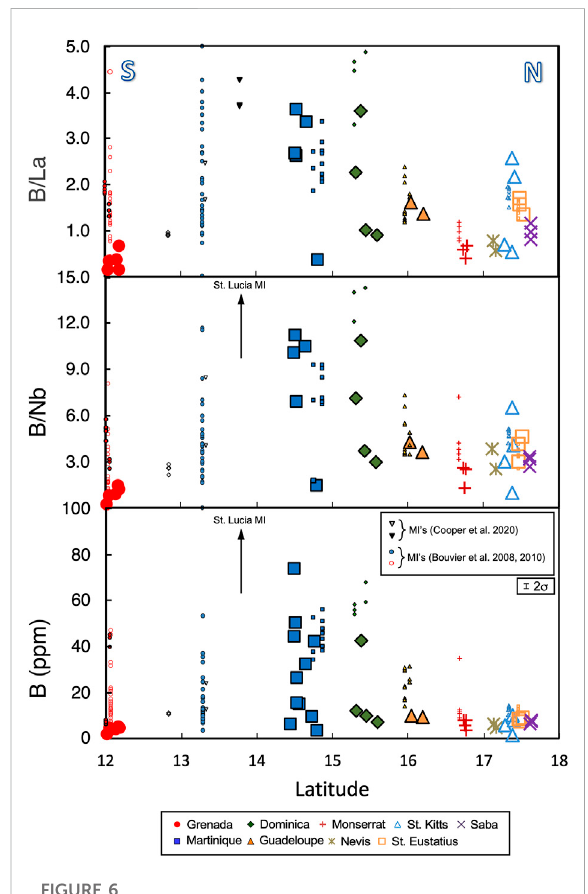
FIGURE 6 Variation of Boron, B/Nb and B/La for the Lesser Antilles Volcanic Arc. Boron is low in Grenada whole rock, enriched in the central islands, reaching peak concentration in St. Lucia and decreasing northward. Ba/Nb and Ba/La are very low for Grenada lava whereas these same ratios are slightly higher in the northernislandssuggestingthatbothNbandLaaremoreenriched in the south. Symbols as in Figure 3 with the addition of Grenada and St. Vincent MI ’ s (small red and blue circles) from Bouvier et al. (2008), Bouvier et al.